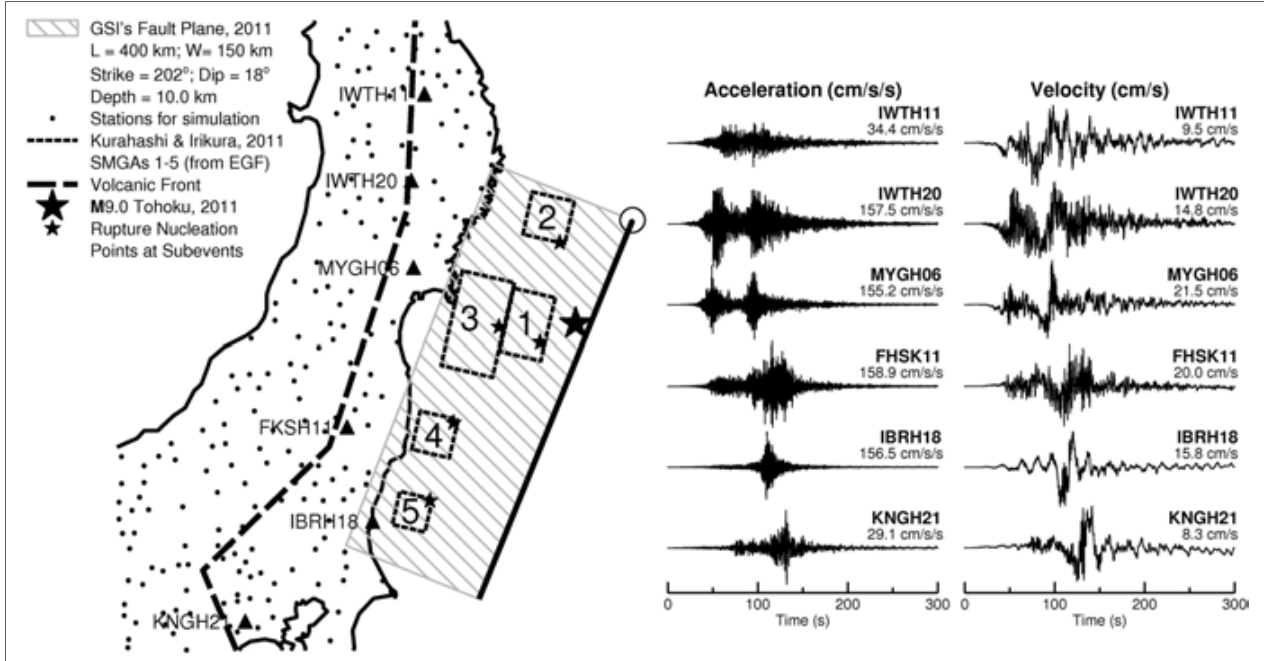
FIGURE 1 | Map showing Tohoku fault plane and stations used for the EXSIM simulations (black dots) at closest distance from the fault plane (Rcd) ranging from 41 to 420km. Graphical representation of the background fault plane for the mainshock, adopted from GSI (2001) finite-fault model, hatched rectangle. Hypocenter of the mainshock, large star close to the trench. Five asperities from empirical Green’s function (EGF) simulations (Kurahashi and Irikura, 2011), dashed rectangles; the star in each strong-motion generation area (SMGA) shows the nucleation point in each asperity. Details of the source model are given in Table 1 . Observed time histories of ground motion (acceleration and velocity) at selected stations (triangles on the map). Numbers at the end of traces are the peak ground accelerations and velocities, respectively.